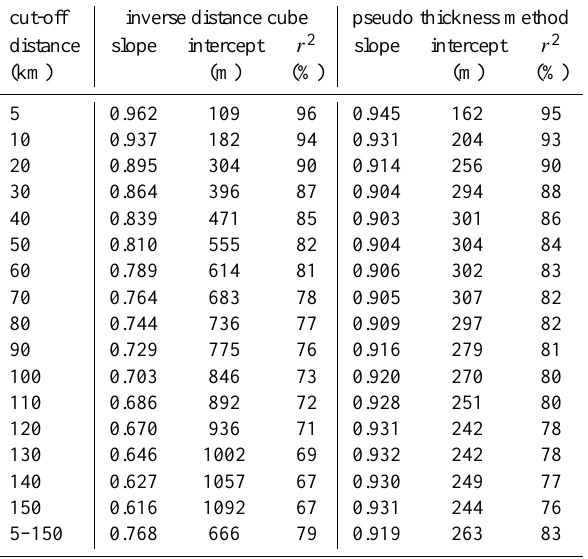
glacial evolution is reported in Young et al. (2011), while the basal hydrology of the region is discussed in Wright et al.